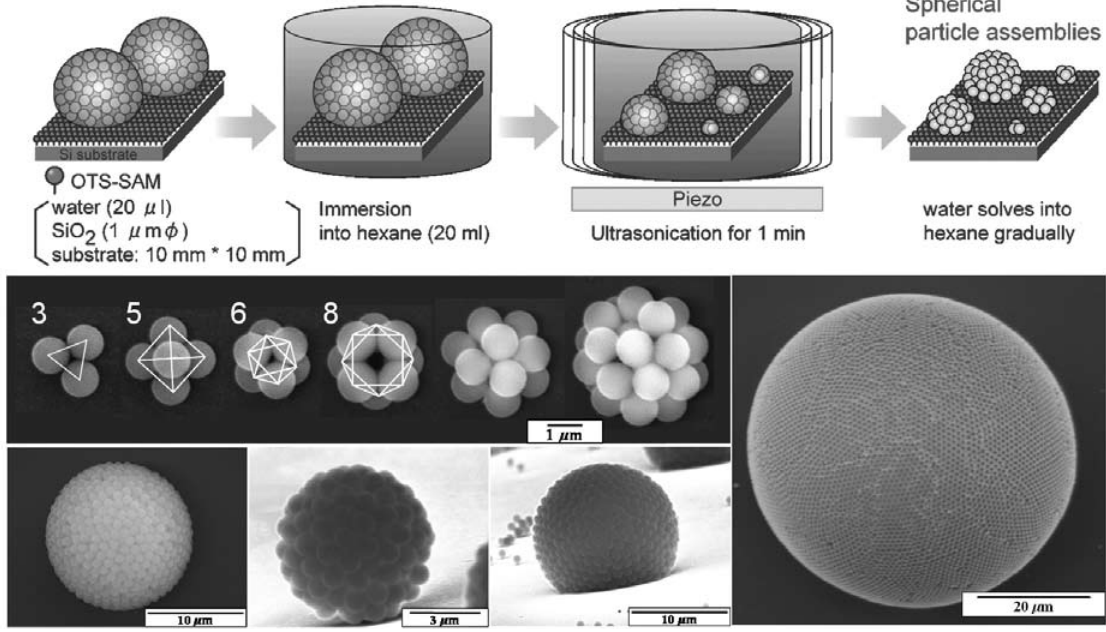
Fig. 4 Conceptual process for fabrication of spherical particle assemblies (first step). SEM micrographs of spherical particle assemblies with differ- ent diameters. Second left: Particle assemblies constructed from a small number of particles such as 3, 5, 6, 8 and so on. Third left: Spherical particle assembly and tilted images. Right: A large spherical particle